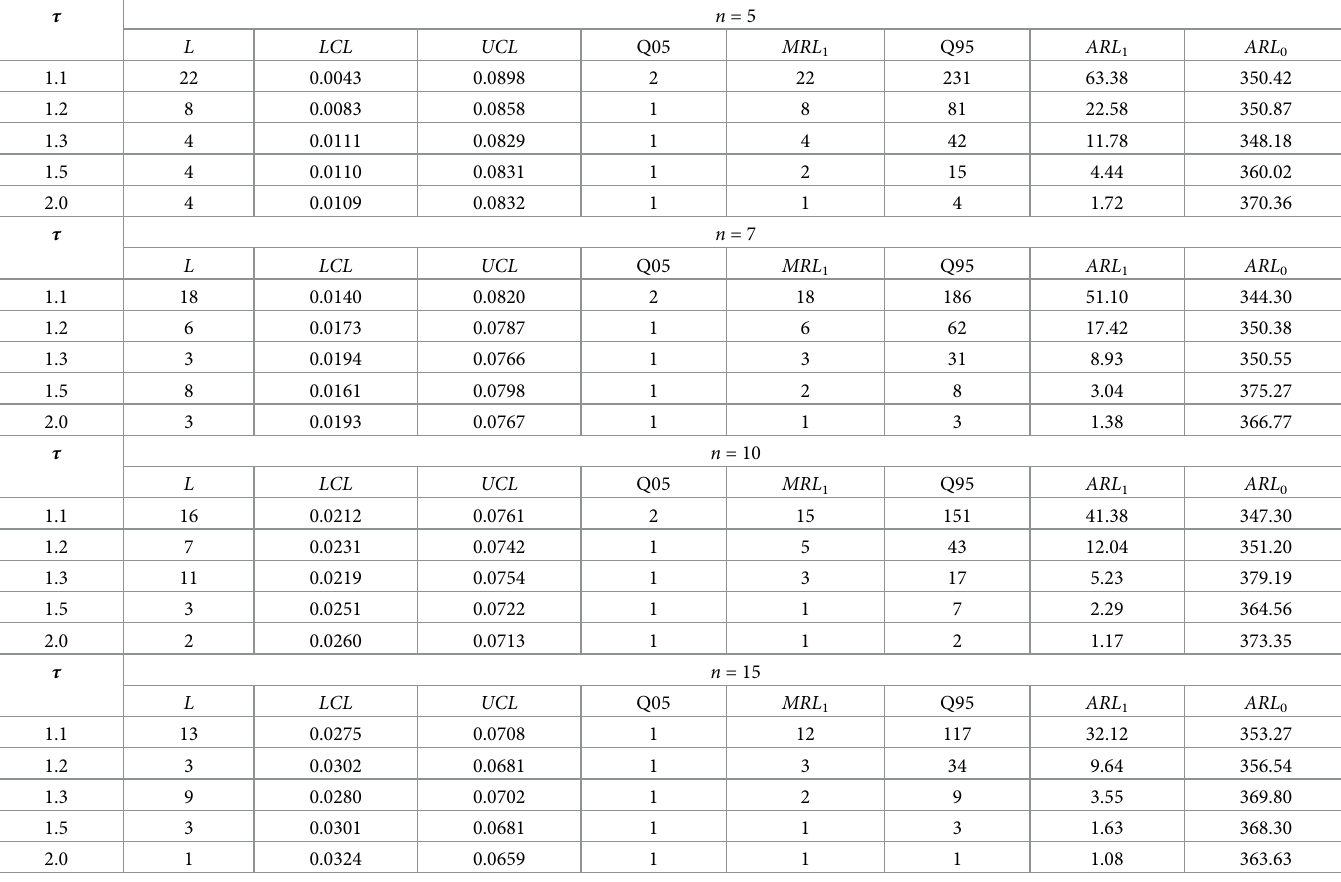
Table 7. Optimal charting parameters and the corresponding Q05, MRL 1 , Q95, ARL 1 and ARL 0 for the MRL -based side sensitive synthetic- γ chart for γ 0 = 0.05, n 2 {5,7,10,15} and τ 2 {1.1,1.2,1.3,1.5,2.0}.